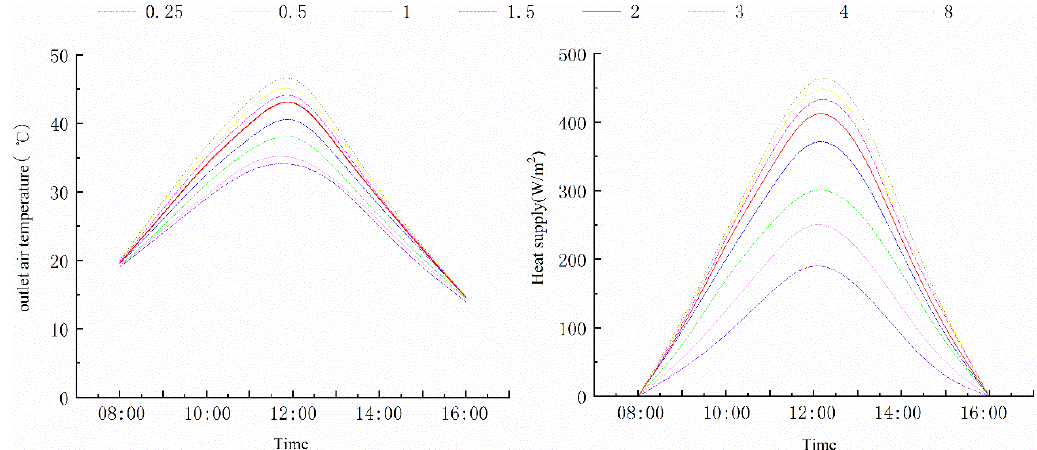
Figure 15. Effect of shape ratio on outlet temperature and heat gain of the solar wall.